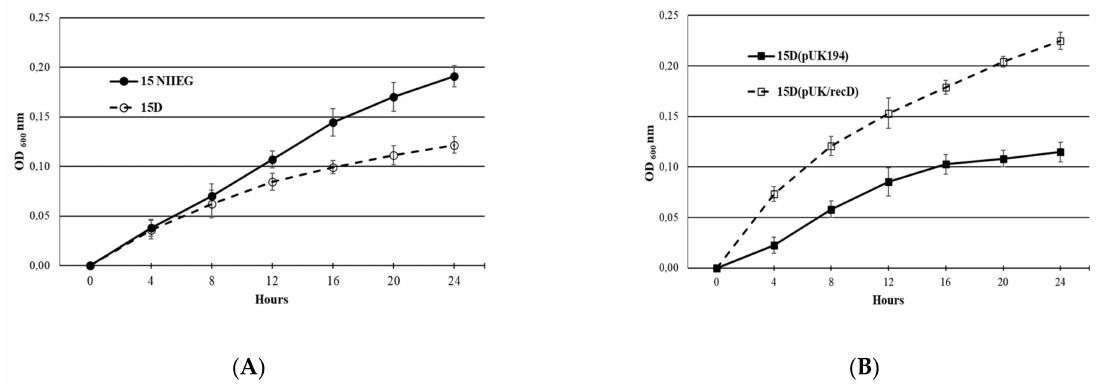
Figure 4. F. tularensis growth in BHI broth at 37 ◦ C, strains: ( A )—15D and 15 NIIEG; ( B )—15D (pUK/recD) and 15D (pUK194).